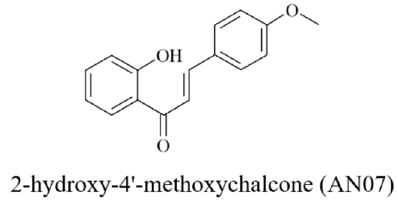
Figure 1. Chemical structure of 2-hydroxy-4 ′ -methoxychalcone (AN07).